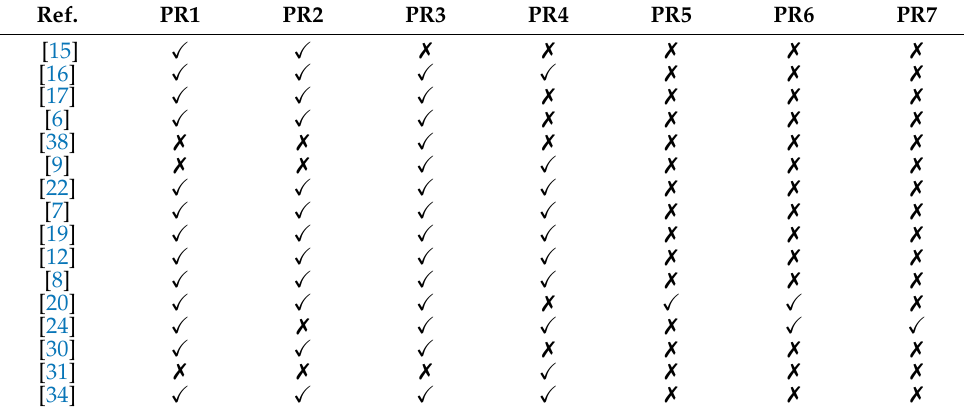
Table 3. Comparative analyses of performance requirements. Ref.